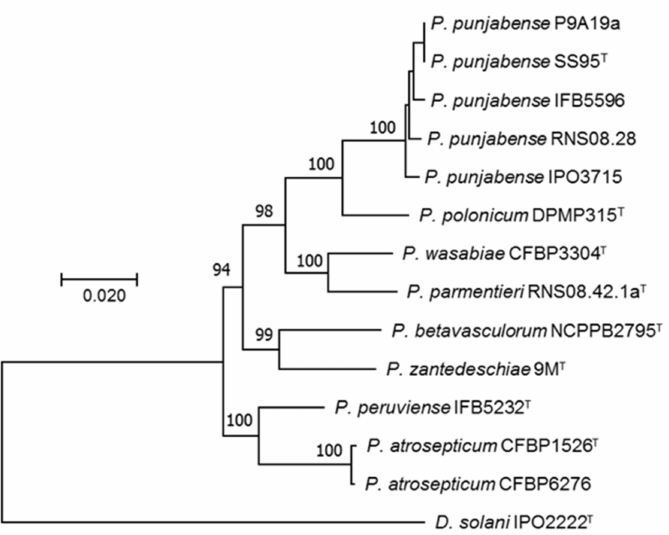
Figure 1. Multi-locus sequence analysis of P. punjabense strains and the most closely related species of the genus Pectobacterium. Maximum likelihood tree built with 14 housekeeping genes ( acnA , fusA , gapA , glyA , groEL , gyrB , mdh , mtlD , purA , recA , rplB , rpoD , rpoS , secY ) using MEGA X [51]. D. solani